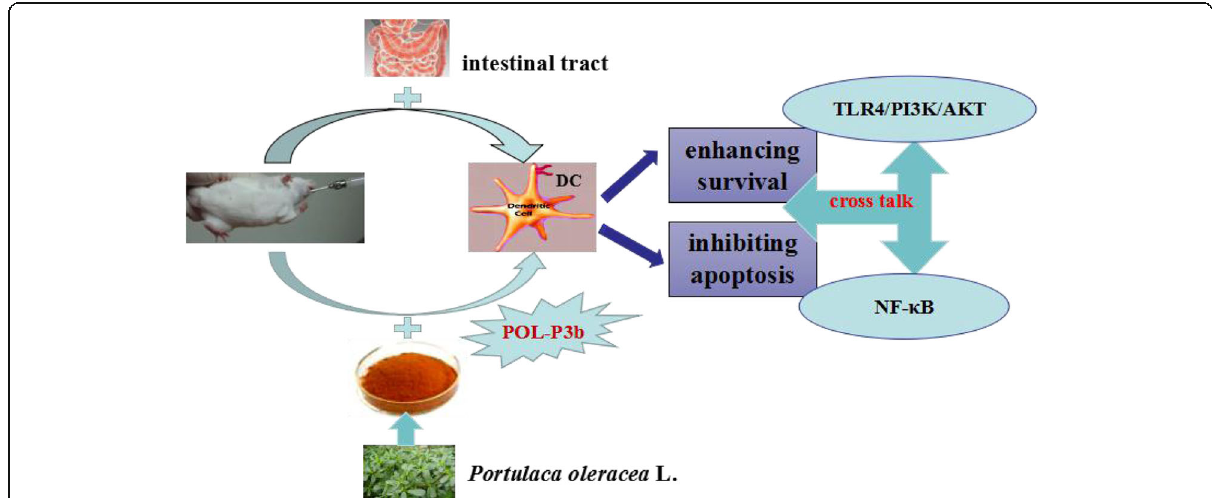
Fig. 6 POL-P3b-induced protection against tumor-induced intestinal DC apoptosis through the cross talk between TLR4/PI3K/AKT and NF- κ B signaling